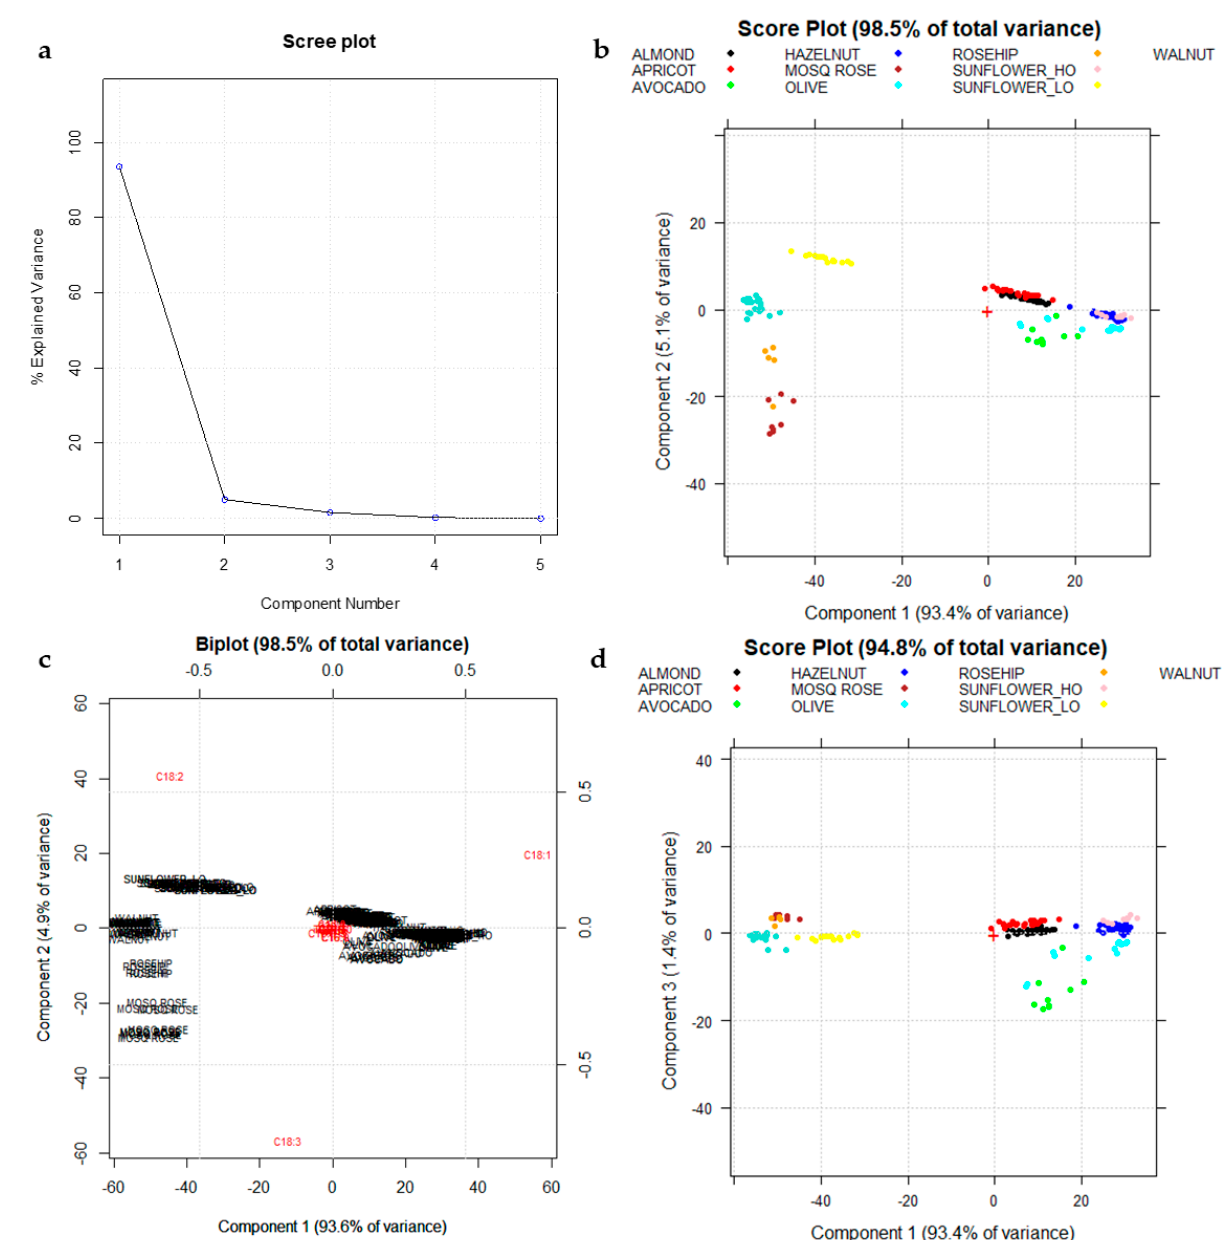
Figure 2. ( a ) Scree plot of A 204,18 ; ( b ) Score plot on the first two principal components (PC1–PC2) calculated using the training set (204 samples). Different species are highlighted in different colors. ( c ) Biplot (score and loading plot) on PC1– PC2; ( d ) Score plot on PC1–PC3. Different species are highlighted in different colors.